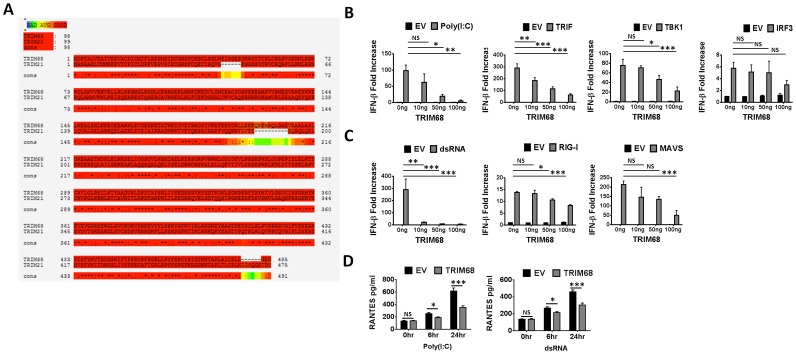
TRIM68 is structurally similar to TRIM21 and down-regulates type I IFN production downstream of TBK1.(A) Human TRIM68 and TRIM21 amino acid sequence alignment using T-Coffee (http://tcoffee.crg.cat/apps/tcoffee/do:regular). An * (asterisk) indicates positions which have a single, fully conserved residue. A: (colon) indicates conservation between groups of strongly similar properties - scoring >0.5 in the Gonnet PAM 250 matrix. A. (period) indicates conservation between groups of weakly similar properties - scoring <0.5 in the Gonnet PAM 250 matrix. (B–C) HeLa cells were transfected with 40 ng full-length IFN-β promoter, empty vector (EV) control and increasing amounts of TRIM68 as indicated for 18 hr and were then stimulated with 20 µg/ml poly(I:C) for 24 hr. In all other cases HEK293T cells were transfected with 40 ng full-length IFN-β promoter and were co-transfected with 50 ng of the relevant promoter drivers TRIF, TBK1, IRF3 (B), or dsRNA, RIG-I, MAVS (C) as well as with empty vector (EV) control and increasing amounts of TRIM68 as indicated. Cells were assayed for relative fold increase of reporter gene activity 18–24 hr post-transfection. (D) HeLa cells were transiently transfected with 1 µg of TRIM68 together with 1 µg/ml 5′ppp-dsRNA for 6 and 24 hr or 18 hr later with 20 µg/ml poly(I:C) for 6 and 24 hr before supernatants were collected for RANTES ELISA. In all cases presented data is graphed from the average of three separate experiments ± S.E.M. *p<0.05 was considered significant.